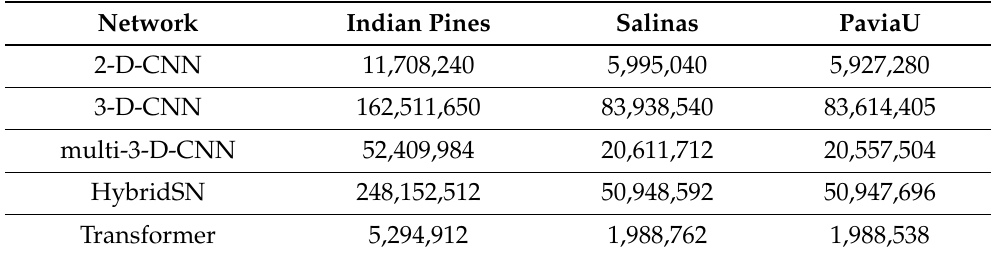
Table 12. Flops of the five methods on the three hyperspectral data sets.